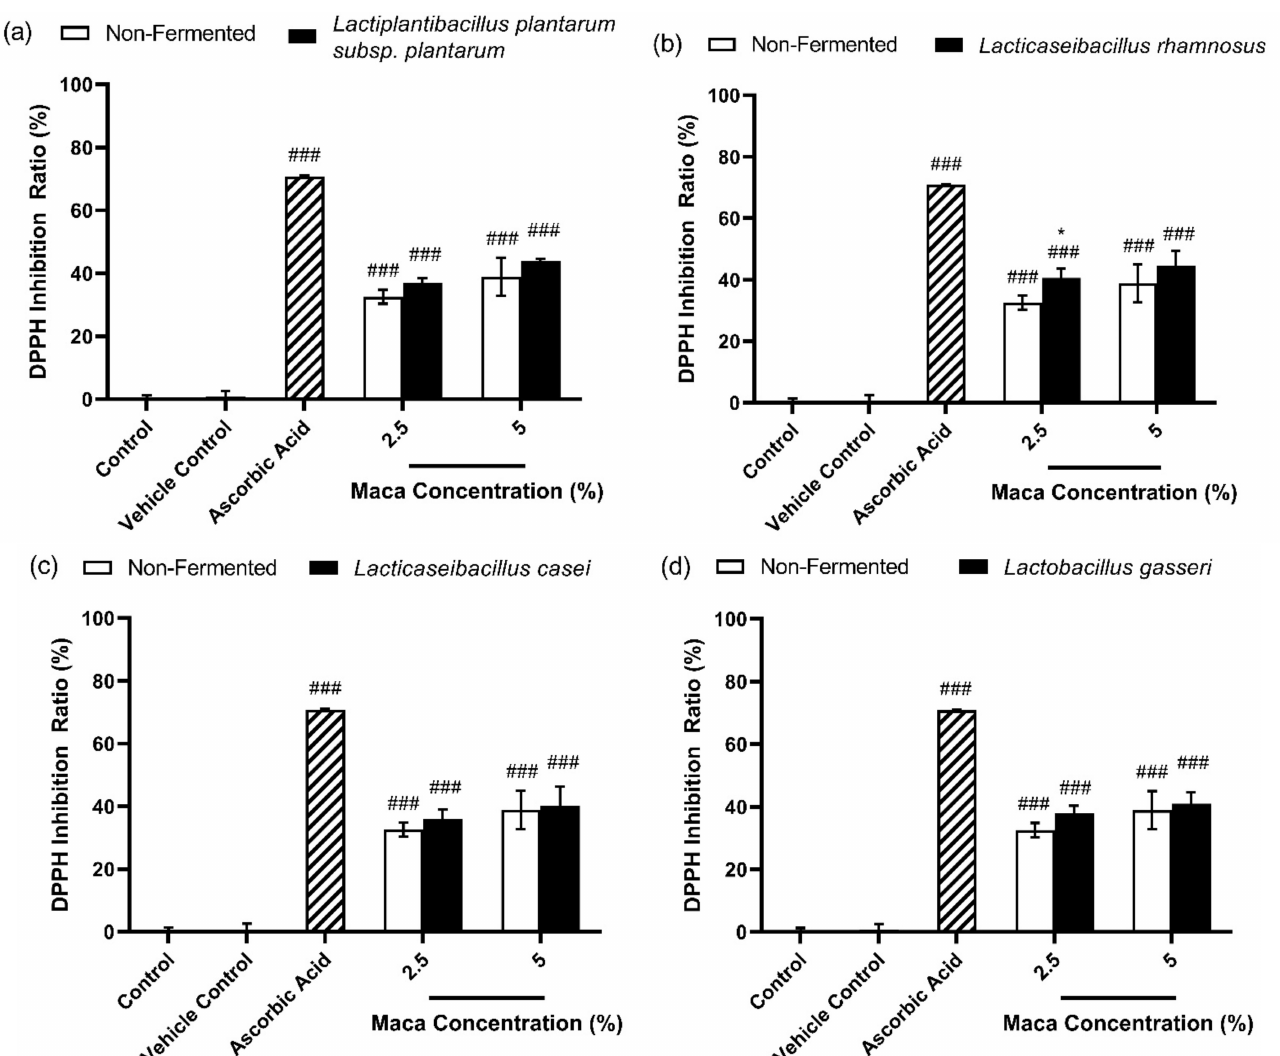
Figure 2. Effects of non-fermented and fermented maca root extracts on antioxidant activity evaluated using the DPPH assay. Treated with maca root extracts fermented using ( a ) Lactiplantibacillus plantarum subsp. plantarum KCTC 3108, ( b ) Lacticaseibacillus rhamnosus KCTC 5033, ( c ) Lacticaseibacillus casei KCTC 3109, and ( d ) Lactobacillus gasseri KCTC 3143. Error bars, mean ± SD. ### p < 0.0005